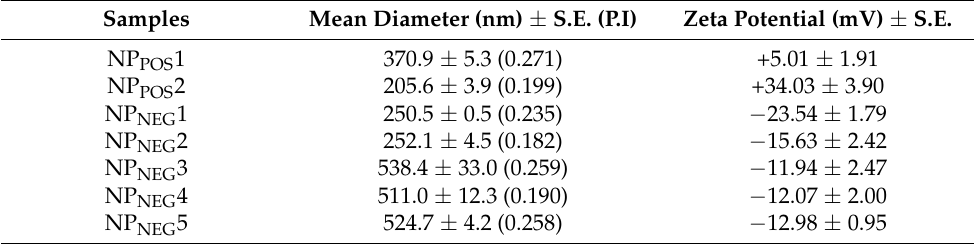
Table 3. Mean diameters and Zeta potential values of uncoated